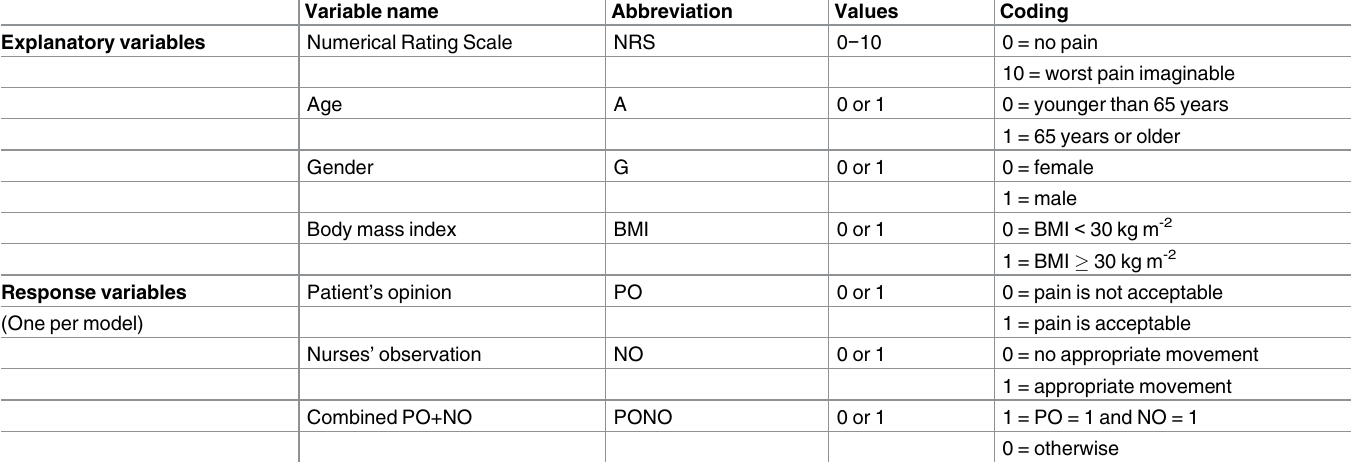
Table 1. Name, abbreviation, values and coding of variables used in the logistic regression models to estimatethe relationships between four explanatory variables and each of three response variables.